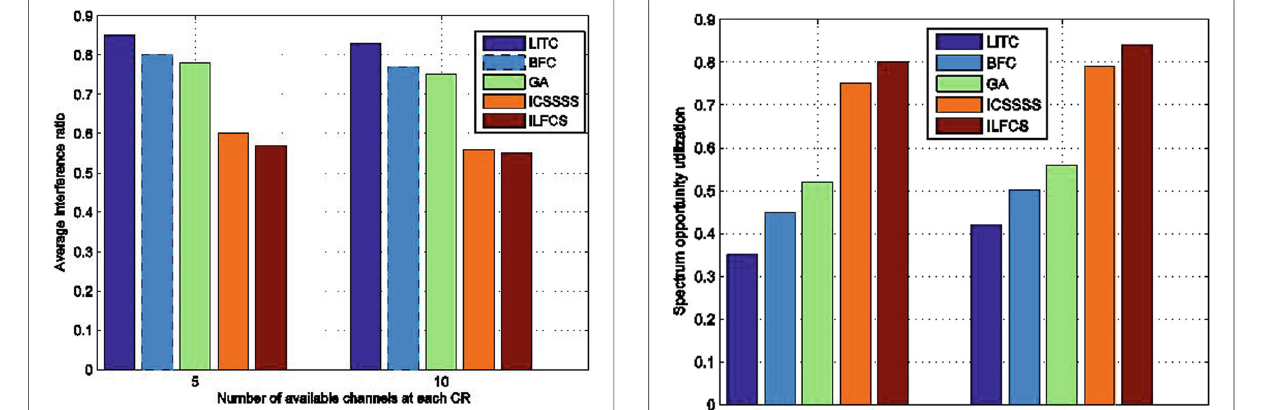
Fig. 19 Spectrum opportunity utilization for LITC, BFC, GA, ICSSSS, and ILFCS in case of high PU activity level. The results of different simulation experiments to measure spectrum opportunity utilization for LITC, BFC, GA, ICSSSS, and ILFCS in case of high PU activity level are shown